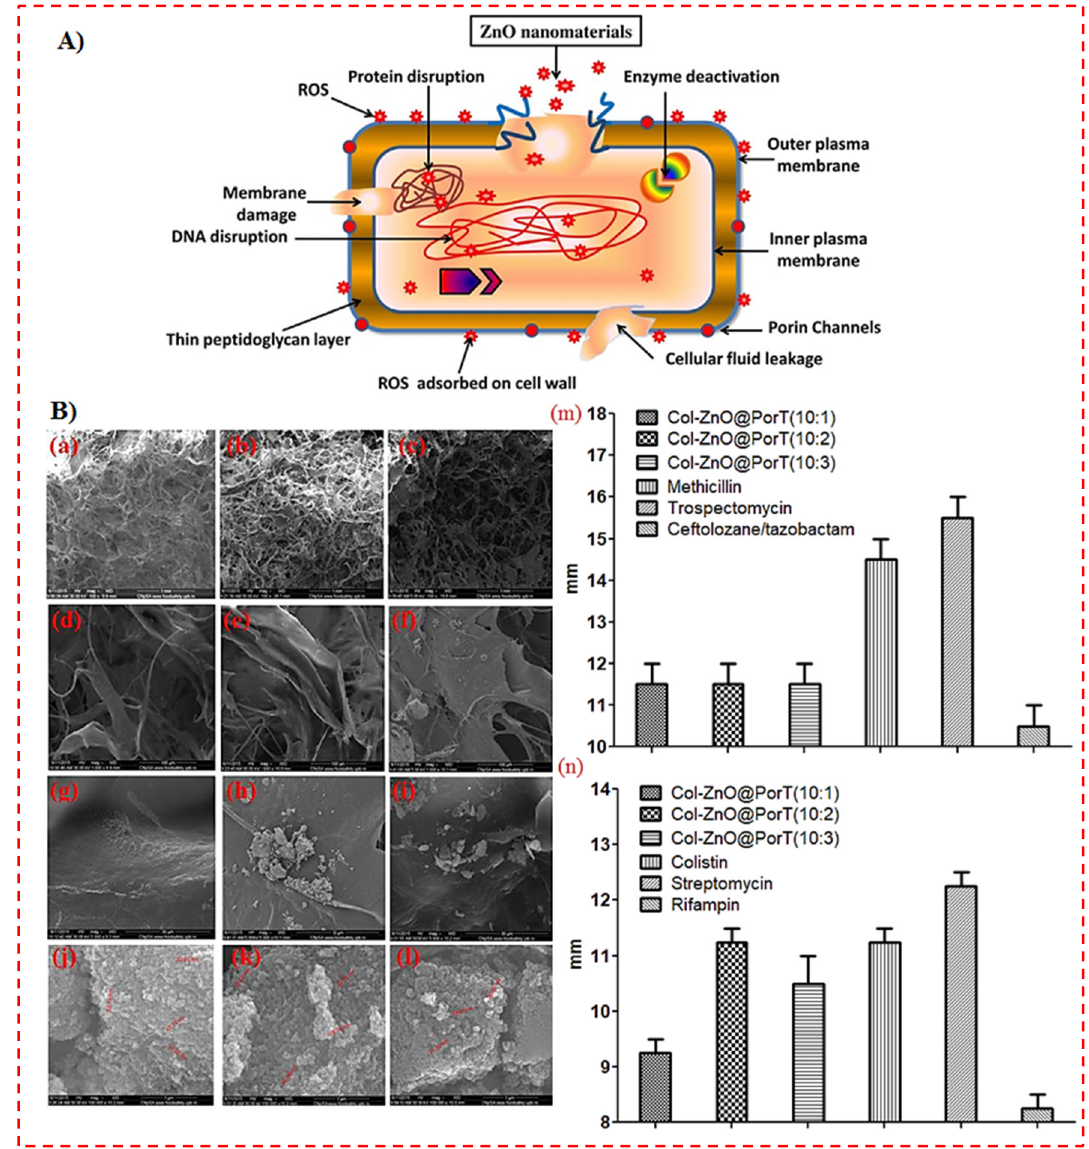
Figure 5. ( A ) The schematic illustration of Gram-negative bacteria cell damage through the production of reactive oxygen species (ROS) [40], and ( B ) scanning electron microscopy (SEM) micrograph obtained at various magnifications, ×100 ( a – c ), ×1000 ( d – f ), ×5000 ( g – i ), and ×100.000 ( j – l ), of the wound dressing, fabricated at the three diverse collagen (Col)/orange oil-functionalized zinc oxide NP (ZnO@PorT) mass ratios: 10:1 ( a , d , g , j ), 10:2 ( b , e , h , k ), and 10:3 ( c , f , I , l ). The diameter of the inhabitation zone (IZ) growth (measured at 20 h soaking duration at 37 °C) was created by different Col-ZnO@PorT dressings, and through typically utilized antibiotics towards S. aureus ( m ) and E. coli ( n ) strains [91].